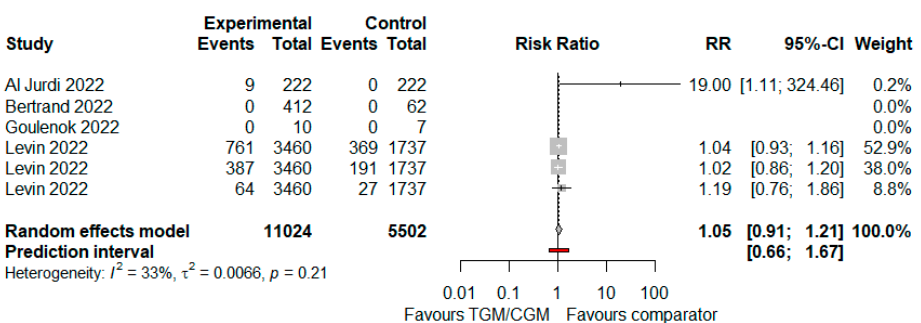
Figure 14. Rate of adverse effects (TGM/CGM vs. comparator). CI, confidence interval; RR, risk ratio; TGM/CGM, tixagevimab/cilgavimab.